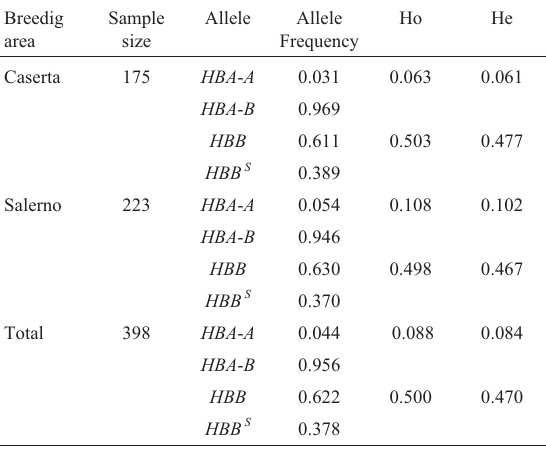
Table 3 - Allele frequencies at the alpha ( HBA ) and beta ( HBB ) systems and observed vs expected heterozygotes in the two province subpopu- lations and in the total population.